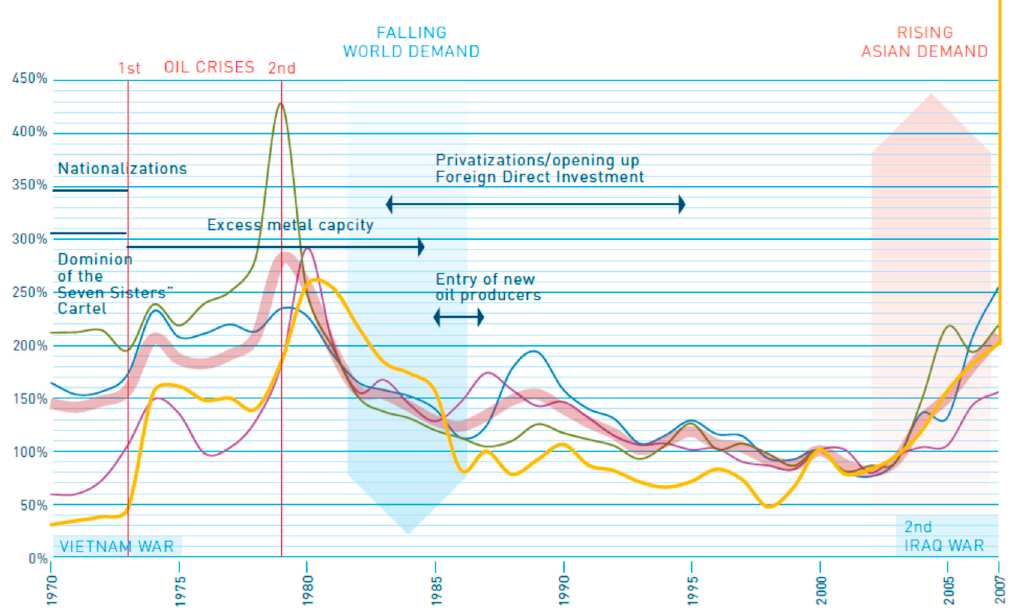
Figure 6. Comparison of crude oil and mineral prices from 1970 to 2007 in constant (2000) prices;